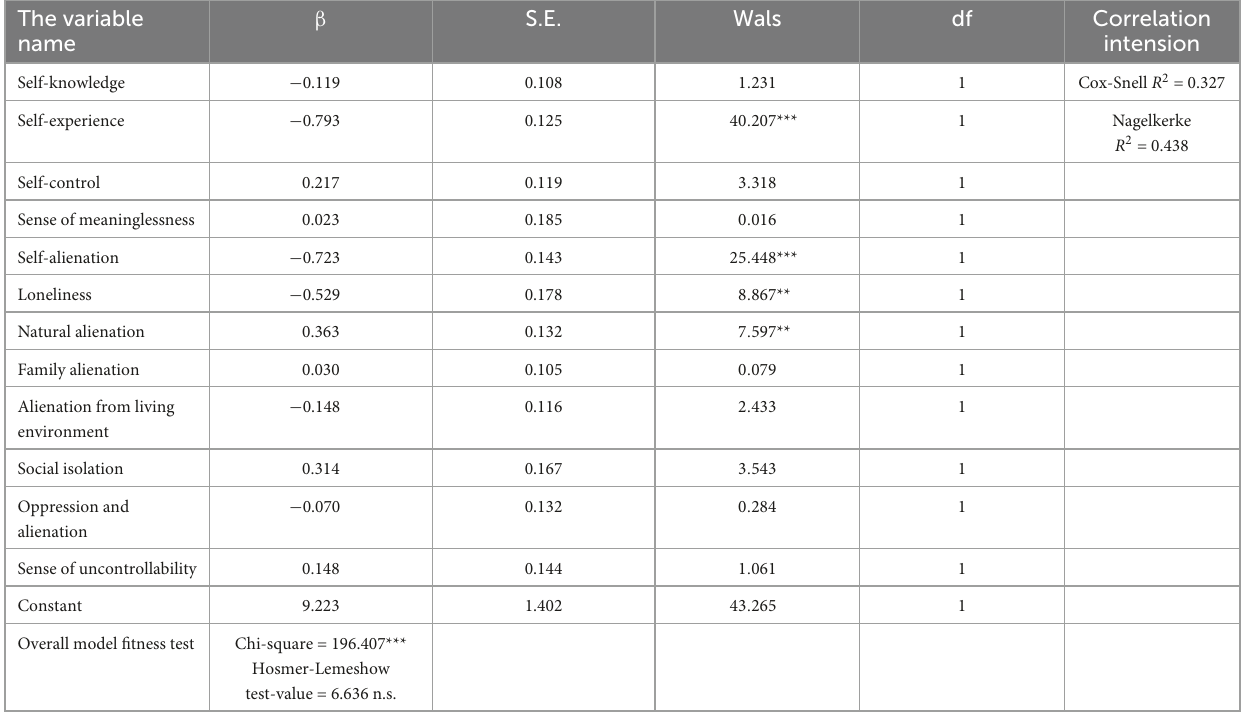
TABLE 7 Summary on the fitness test of the whole model and the significance test of individual parameters.